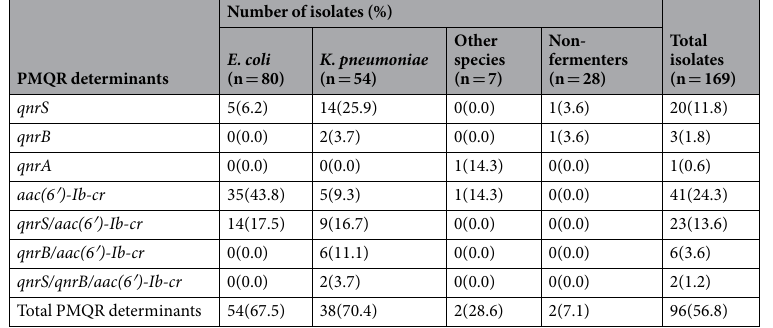
Table 3. Prevalence of PMQR genes in various bacterial species. PMQR, plasmid-mediated quinolones resistance; Other species, C. freundii, E. aerogenes, E. cloaceae, K. oxytoca , and P. mirabilis ; non-fermenters, A. baumannii and P. aeruginosa . Percentages were calculated relative to the number of isolates in each